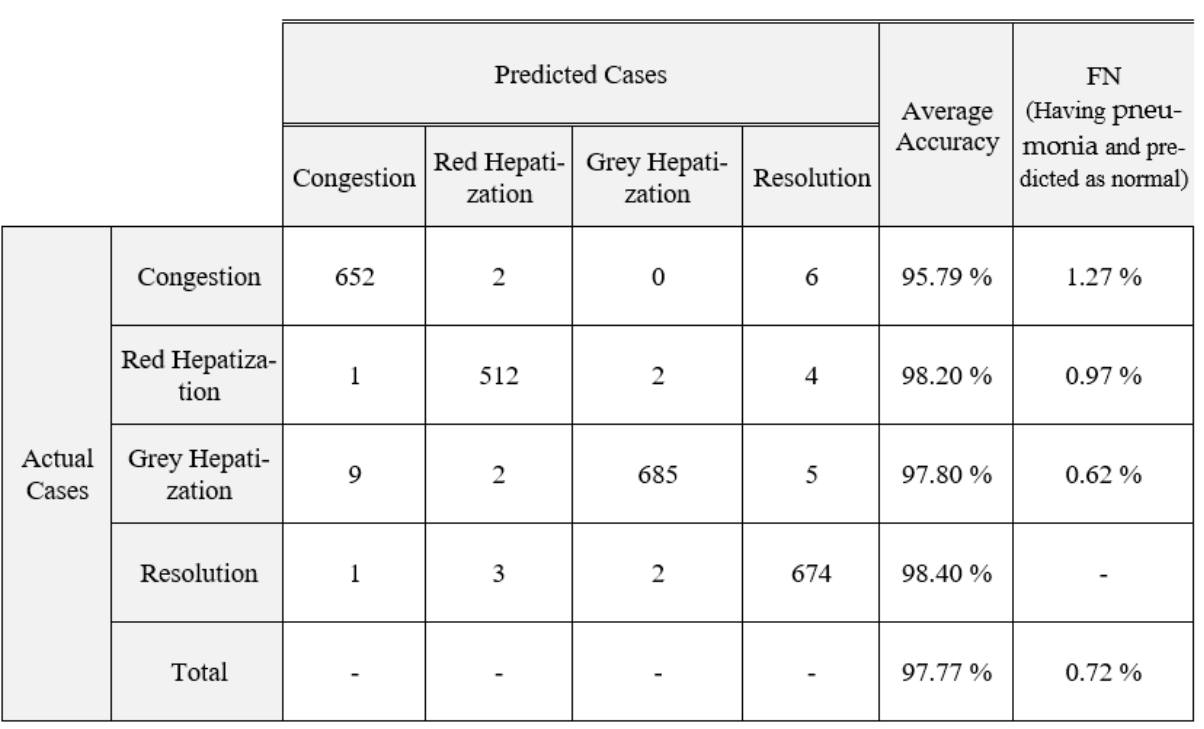
Figure 6. Confusion matrix for multi-classification for the improved BoxENet model without seg- mented X-ray.